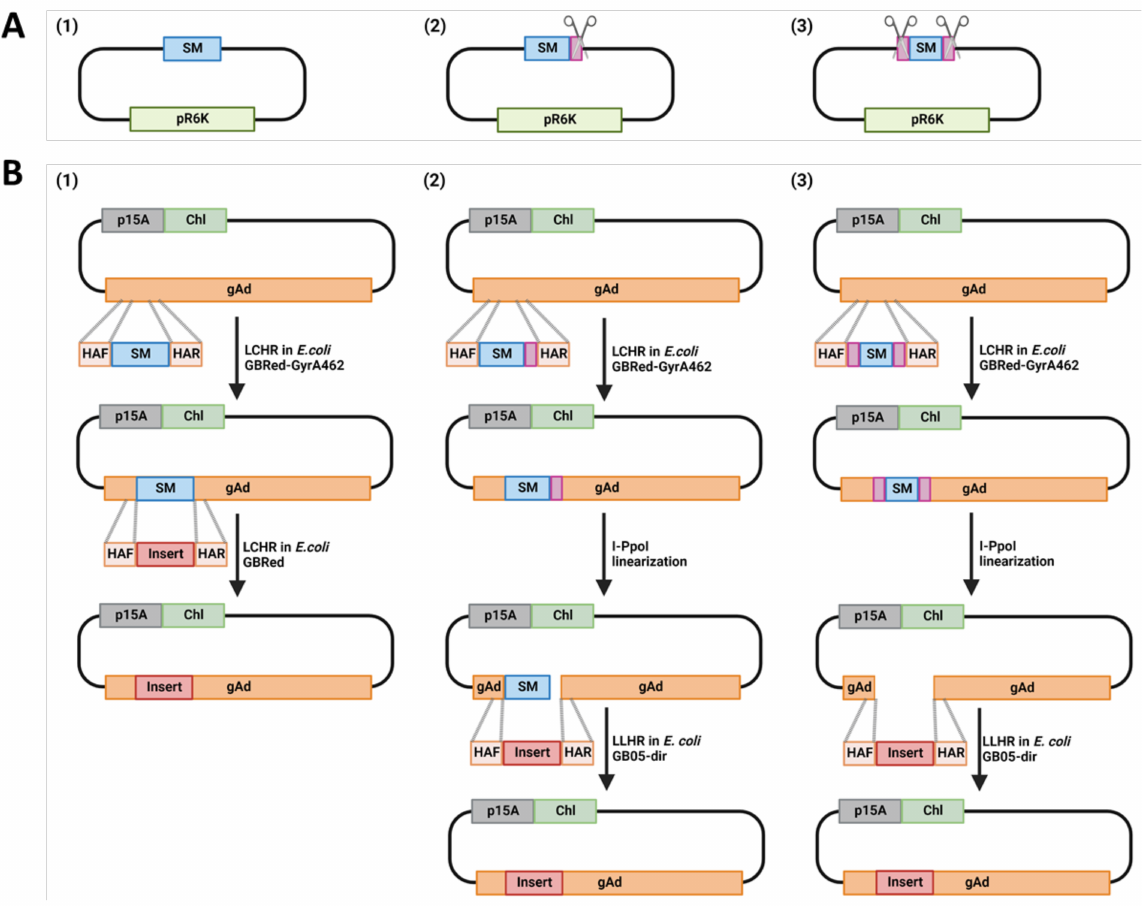
Figure 2. Homologous recombination strategy for adenovirus genome engineering. ( A ). The three types of selection marker (SM)-containing PCR templates for counter-selection are displayed. (1) SM only; (2) SM with a single flanking I-PpoI site; (3) SM with I-PpoI flanking both ends of the SM, for detail, see also Figure S1. ( B ). The three counter-selection strategies with different SM PCR-templates. All strategies shared the same first step: ampicillin-mediated positive selection to insert the selection marker cassette ( ccdB-Amp ) generated from different PCR-templates as shown in A. The small pink rectangles next to SM in B (2) and (3) show the I-PpoI sites. The adenoviral genome containing plasmid and the ccdB-Amp cassette flanked by homologous arms to the target region of the adenoviral genome are co-electroporated into the E. coli strain GBRed-GyrA462, in which the λ Red–mediated linear–circular homologous recombination (LCHR) takes place to insert the ccdB-Amp cassette into the desired site. The three strategies differ on the counter-selection step: (1) counter-selection